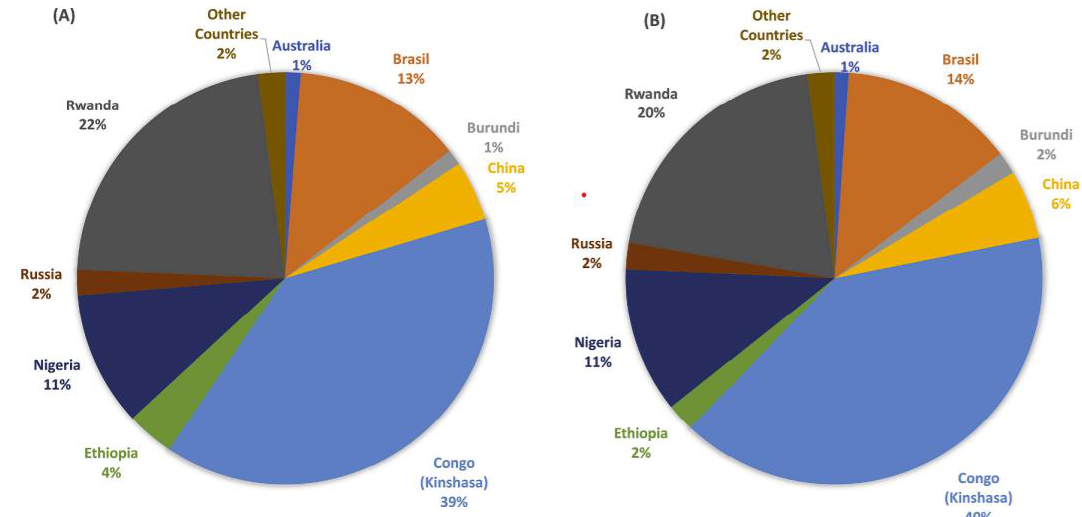
Figure 1. World tantalum production in 2018 ( A ) and 2019 ( B ).